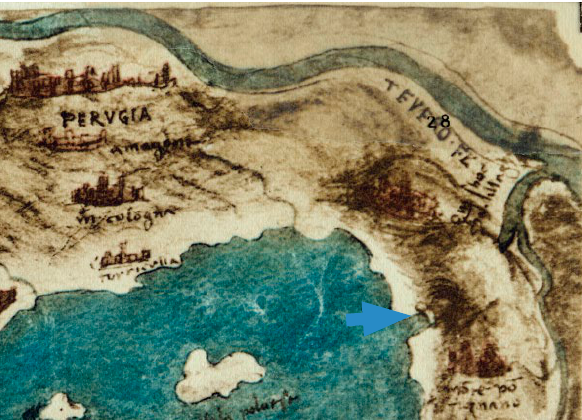
Figure 4. Detail of the dried-out canal, called “Trasumeno”, from the Map of Tuscany , Windsor, Royal Library, 12277.